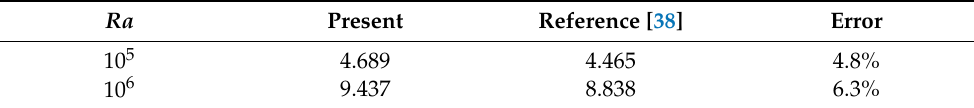
Figure 1. The physical model for validation of numerical model. Table 2. Comparisons of the numerical results and that presented in Reference [38]. Ra Present Reference [38]